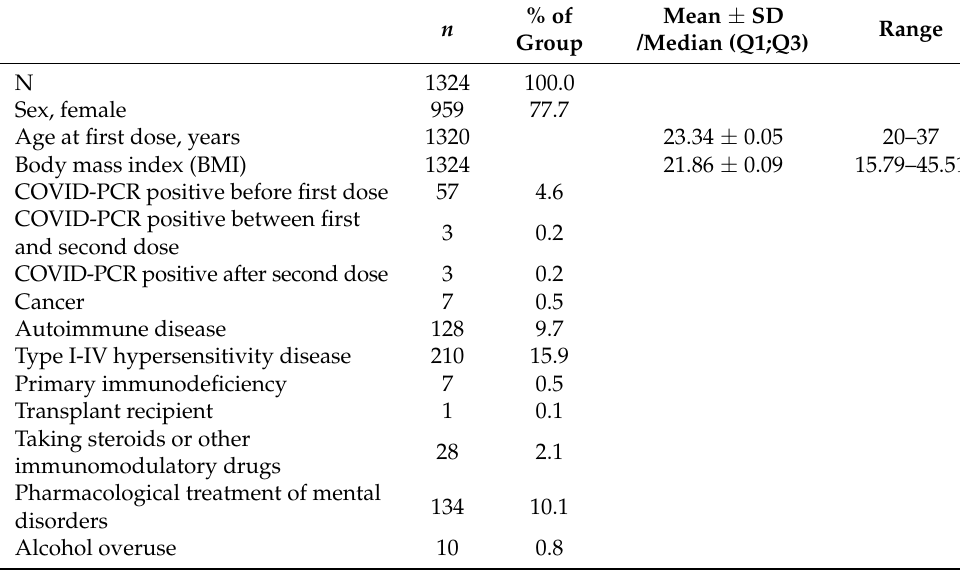
Table 1. Characteristics of the group.